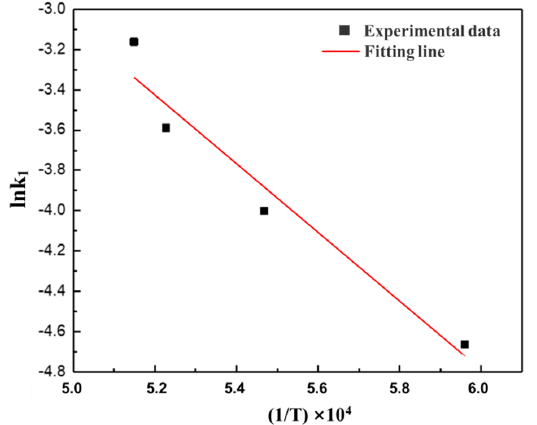
Figure 10. Variation in reaction rate constant k 1 with increasing (1/ T ) × 10 4 in the first stage of decarburization when blowing pure O 2 .